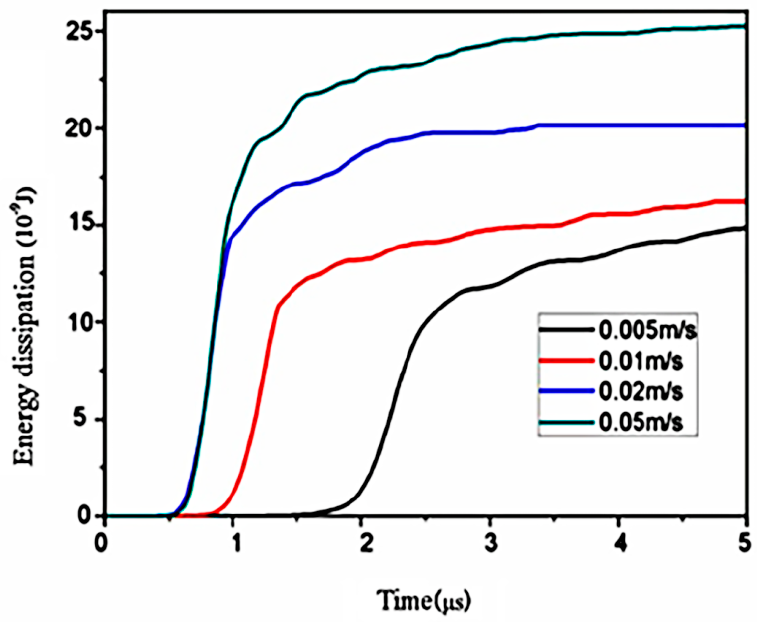
simulation calculation.